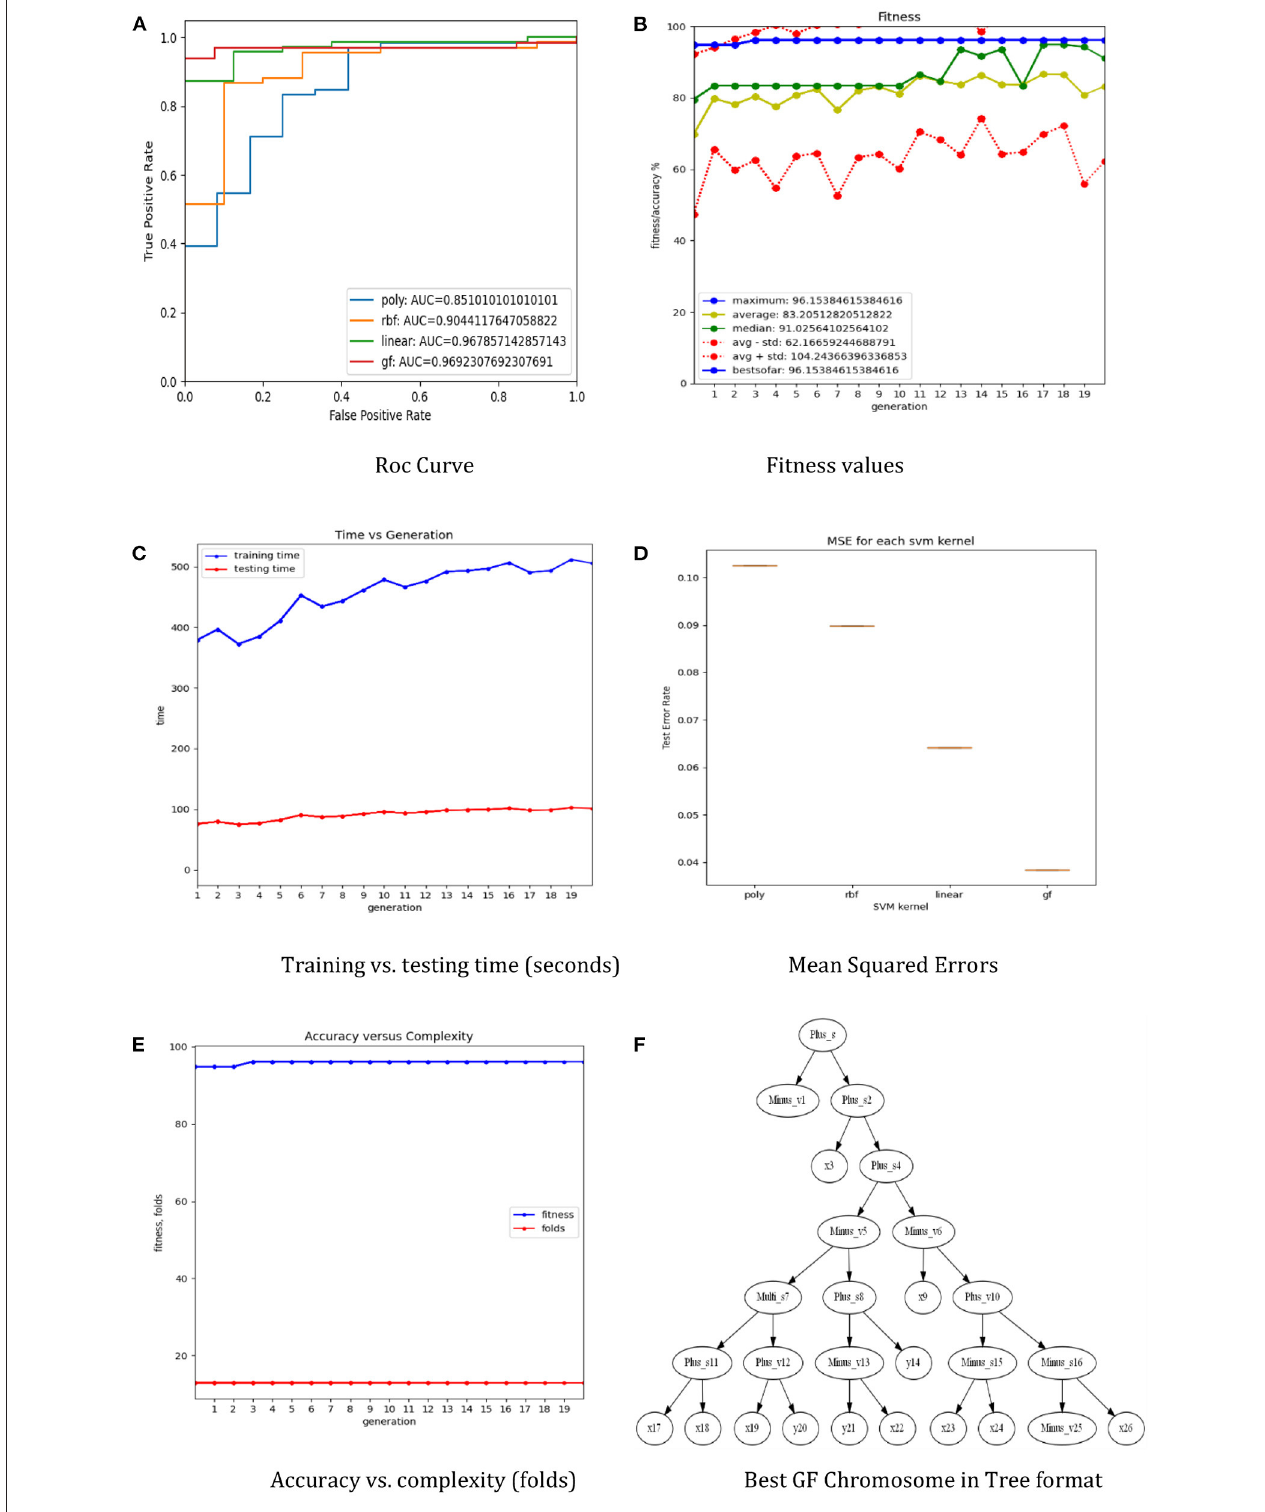
FIGURE 2 | The results of the GF toolbox for the lung cancer dataset. (A) Roc curve. (B) Fitness values. (C) Training vs. testing time (seconds). (D) Mean squared errors. (E) Accuracy vs. complexity (folds). (F) Best GF chromosome in tree format.